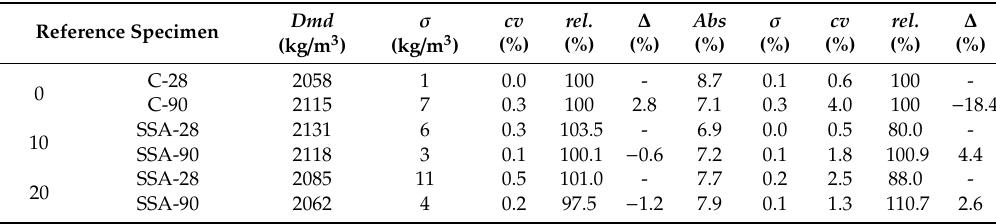
Table 4. Dmd and Abs of specimens cured for 28 (from [37]) and 90 days ( σ : standard deviation, c v : coefficient of variation, rel : relative value compared to reference specimens with same curing age, ∆ : increase in each mixture between the two curing ages).